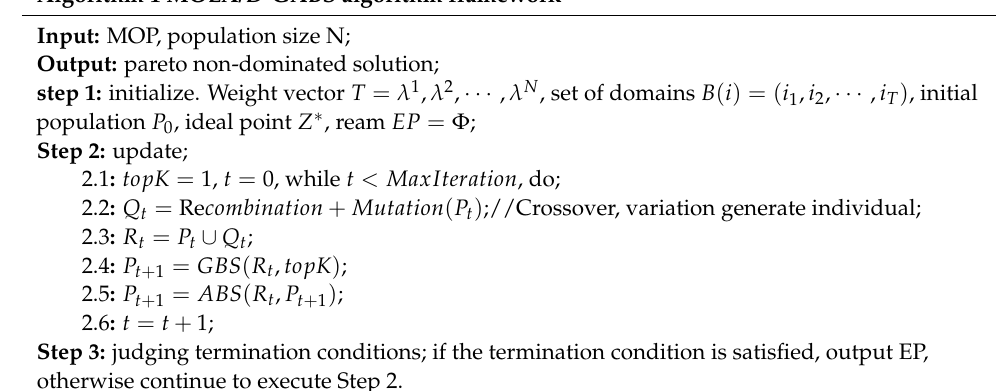
Algorithm 1 MOEA/D-GABS algorithm framework